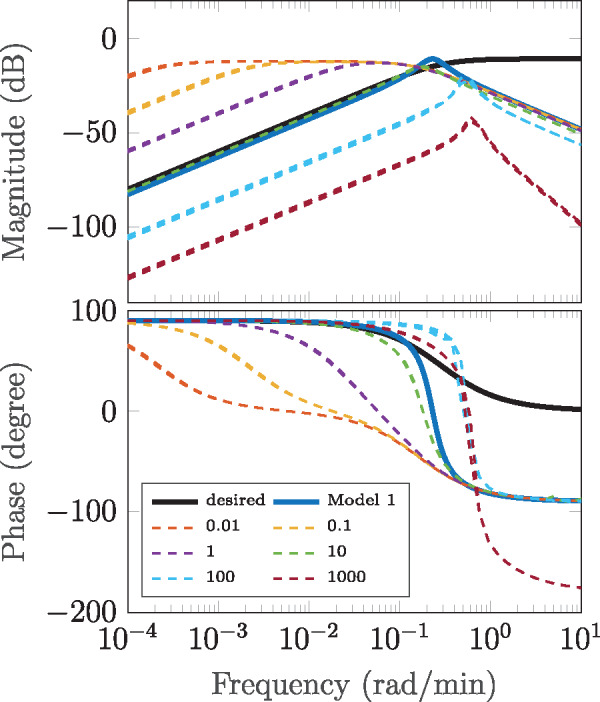
Bode plot of desired model (solid black) and linear Model 1 (solid cyan). In dashed lines, magnitude and phase of output of nonlinear Model 2 subject to u(t)=A0+A· sin(ωt). Different colors indicate different values of A0. Several values for A are plotted (lying on top of each other).